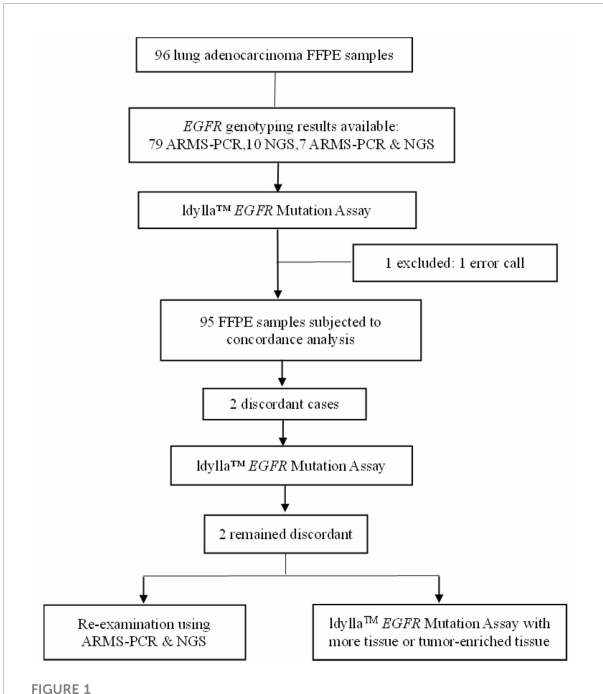
FIGURE 1 Flowchart of this testing strategy for Chinese NSCLC